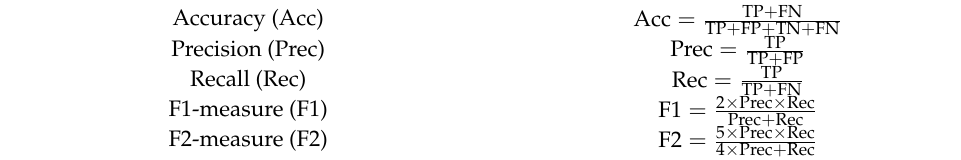
Table 16. Performance indices.